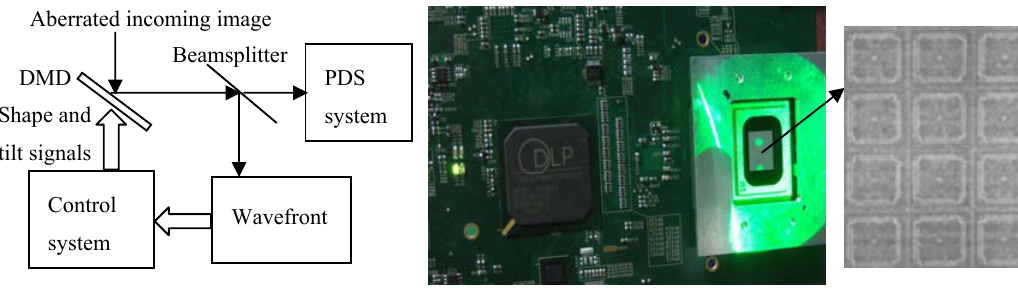
(c) DMD with1024×768 cell (b) Circuit board